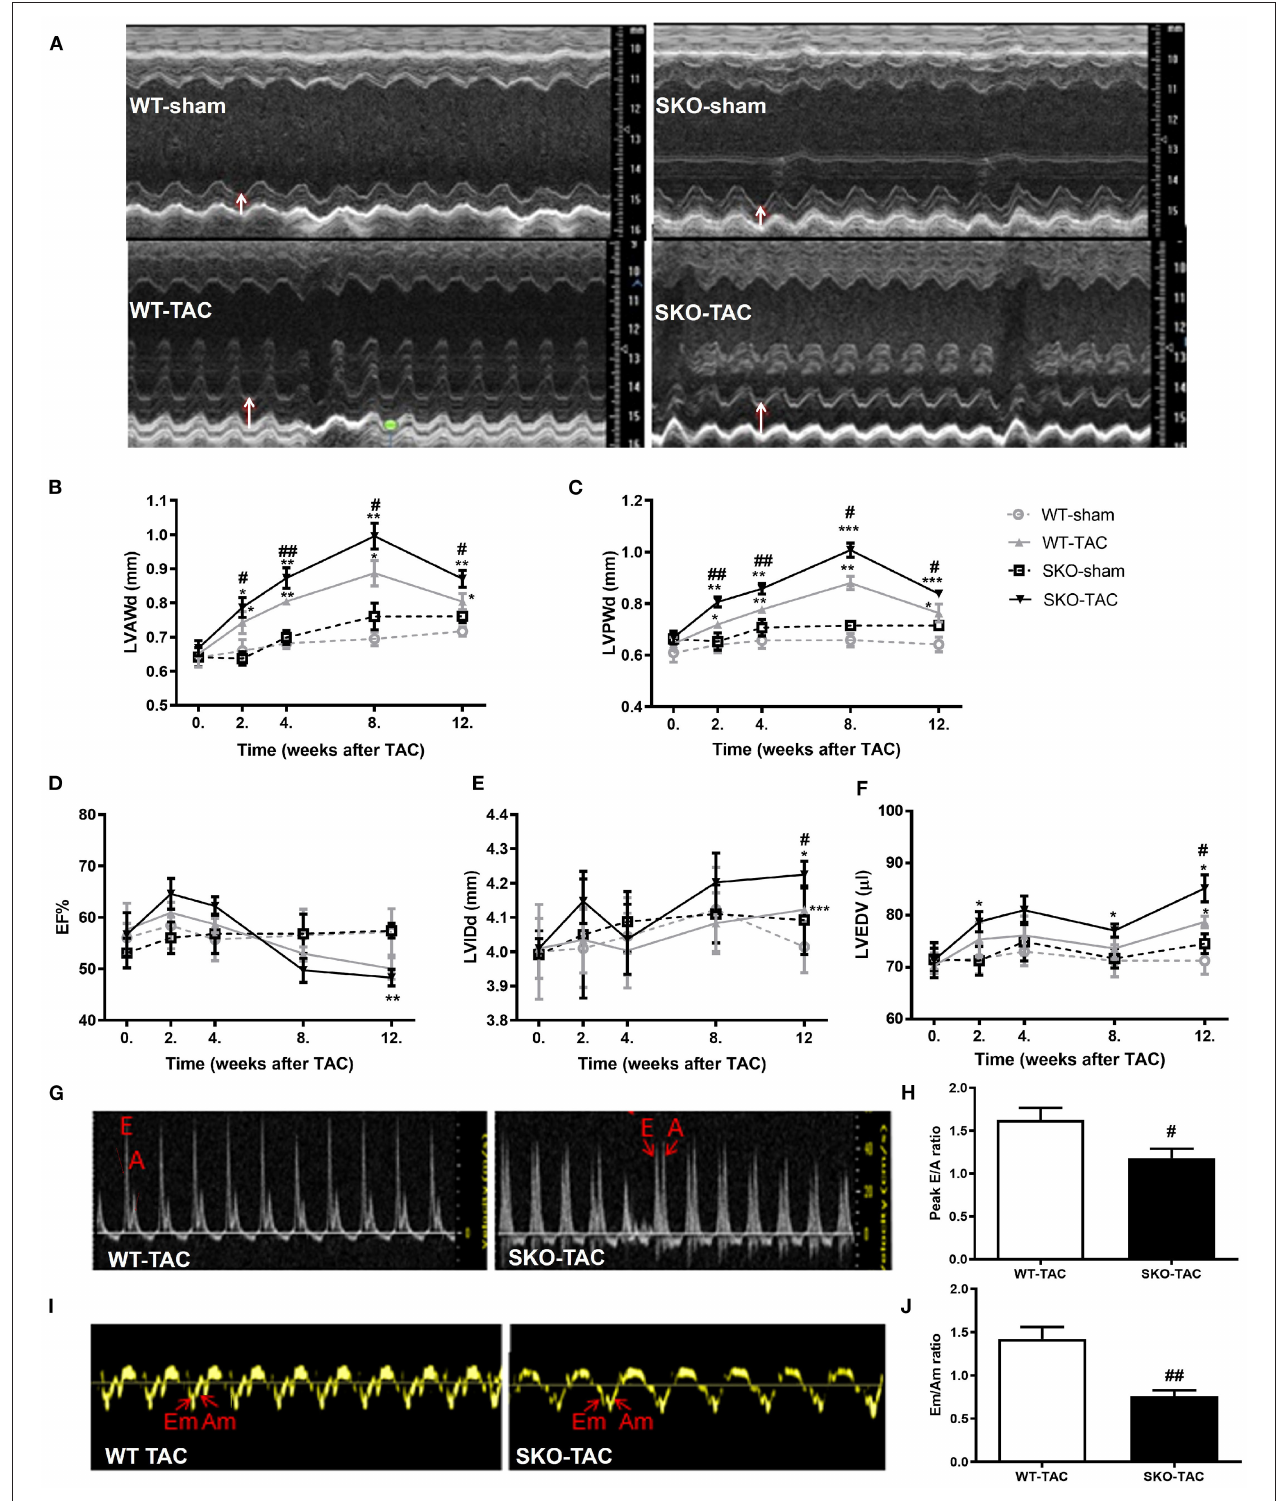
FIGURE 2 | Seipin deficiency induced severe cardiac hypertrophy and left ventricular dysfunction at 12 weeks after TAC by echocardiography. (A) Representative M-mode echocardiographs; white arrows represent the left ventricular posterior wall thickness (LVPWd); (B) left ventricular anterior wall thickness in diastole (LVAWd); (C) LVPWd; (D) ejection fraction (EF%); (E) left ventricular internal diameter in diastole (LVIDd); (F) left ventricular end-diastolic volume (LVEDV); (G) Representative transmitral Doppler flow profile; (H) Peak E/A ratio; (I) Representative Doppler images of the basal inferolateral LV wall; and (J) Em/Am ratio.* P < 0.05, ** P < 0.01, *** P < 0.001, effect of TAC; # P < 0.05, ## P < 0.01, effect of genotype. WT, Wild-type; SKO, seipin knockout; TAC, transverse aortic constriction, late diastolic mitral transmitral flow velocity (A), early diastolic mitral transmitral flow velocity (E), late diastolic velocity (Am), and early diastolic velocity (Em). Frontiers in Cardiovascular Medicine |